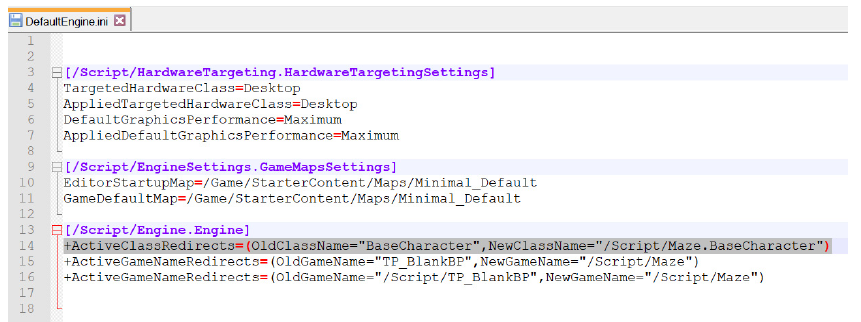
Figure 4. Solution for exporting the hierarchy problem.